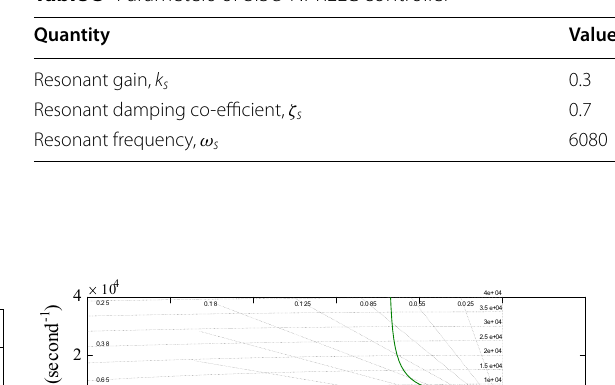
Table 3 Parameters of SISO NI‑RLLC